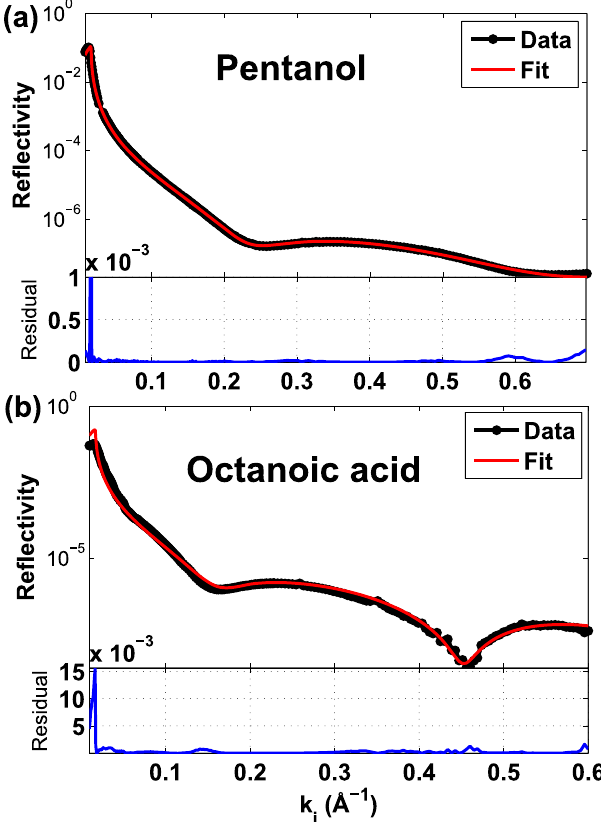
Figure 5. The best fit surface models. The best surface model (red line) fitted to the reflectivity data (black dots) of ( a ) pentanol and ( b ) octanoic acid on calcite {10.4}. Residuals for the fit are plotted below each